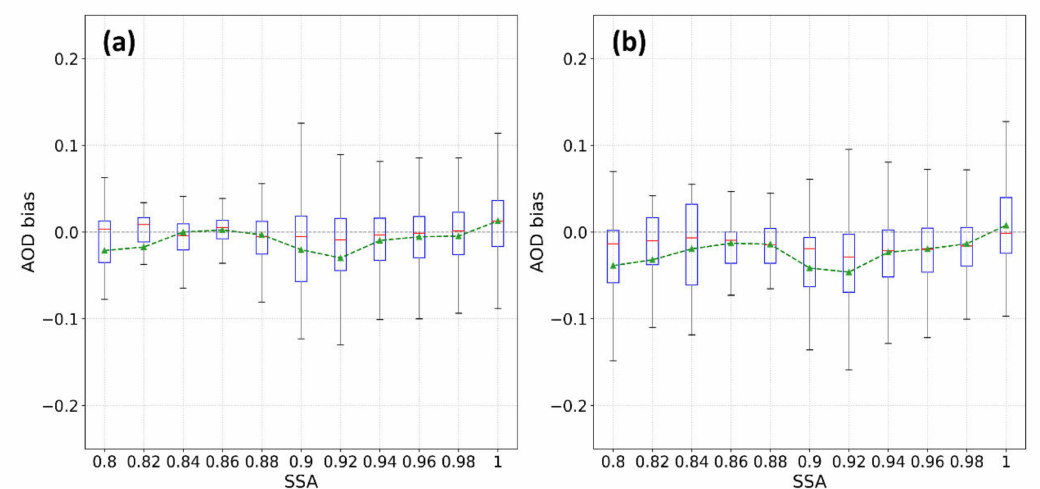
Figure 5. The same as Figure 4 but as a function of AERONET single scattering albedo (SSA, 550 nm) values. Box plots of AOD bias (in grey) for ERF-estimated AOD ( a ) and MODIS AODs ( b ). In the real atmosphere, WVC has implications on aerosol composition and size.